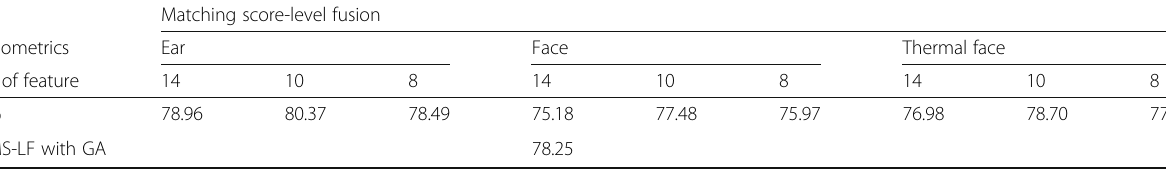
Table 6 Matching score-level fusion with DT